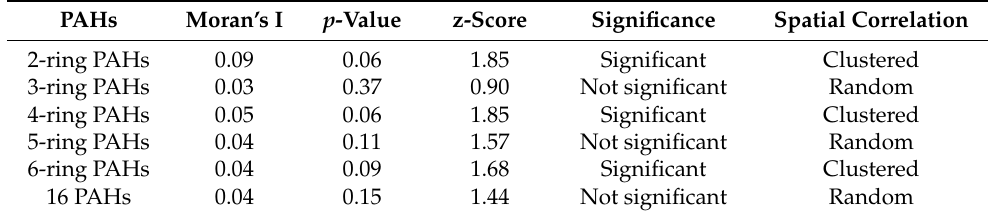
Table 2. Spatial autocorrelation analysis of the soil ∑ 16 PAHs and PAHs with different ring num- bers. PAHs Moran’s I z-Score Significance